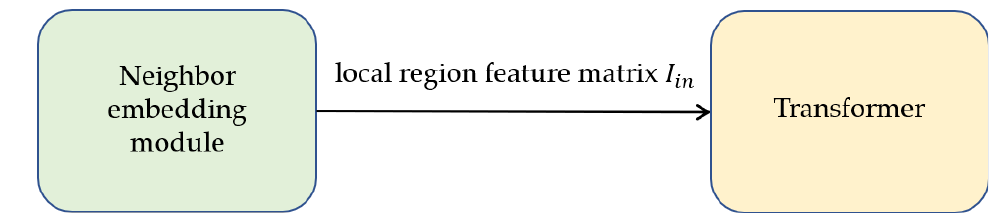
Figure 6. Local transformer structure.